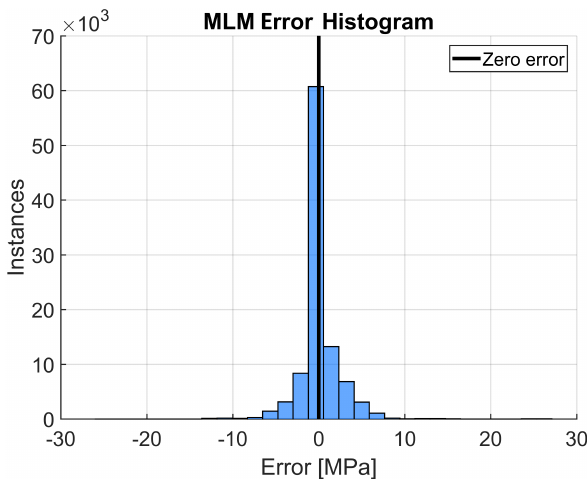
Figure 9. Error histogram for the MLM with 30 bins and a bin width of around 1.8 MPa. The results displayed are the difference between the experimental and predicted stress values.